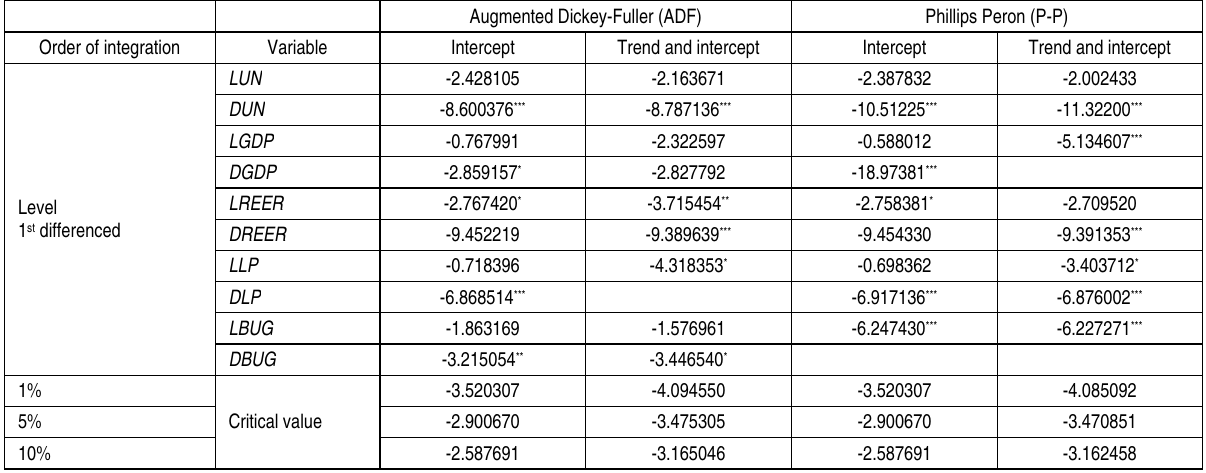
Table 1. Unit root tests results